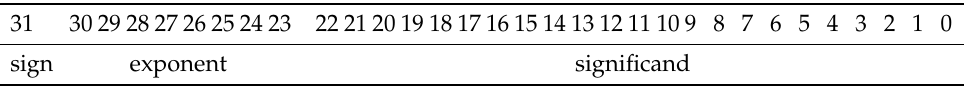
Table 1. Single precision floating-point binary32 representation.